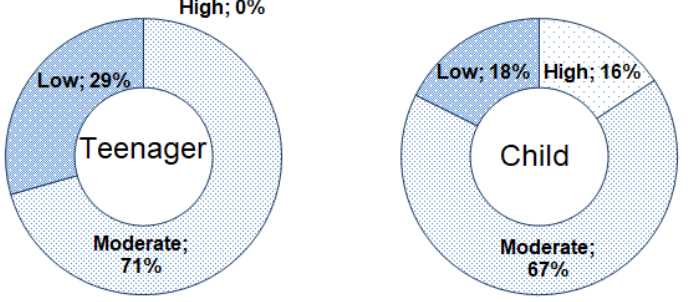
Figure 5. Low, moderate, and high sleep satisfaction of the teenager and child corresponding to categories: Very dissatisfied and dissatisfied (1) + (2); moderate (3), as well as satisfied and very satisfied (4) + (5).